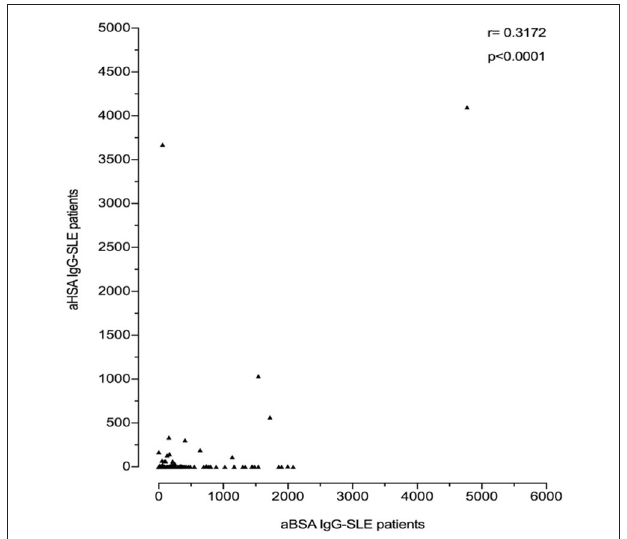
FIGURE 5 | Correlation of anti-BSA IgG level and anti-HSA IgG level in all SLE patients ( n = 180). A significant correlation was seen between SLE patients and healthy controls with a correlation coefficient r = 0.3172 by Spearman’s rank correlation ( p <